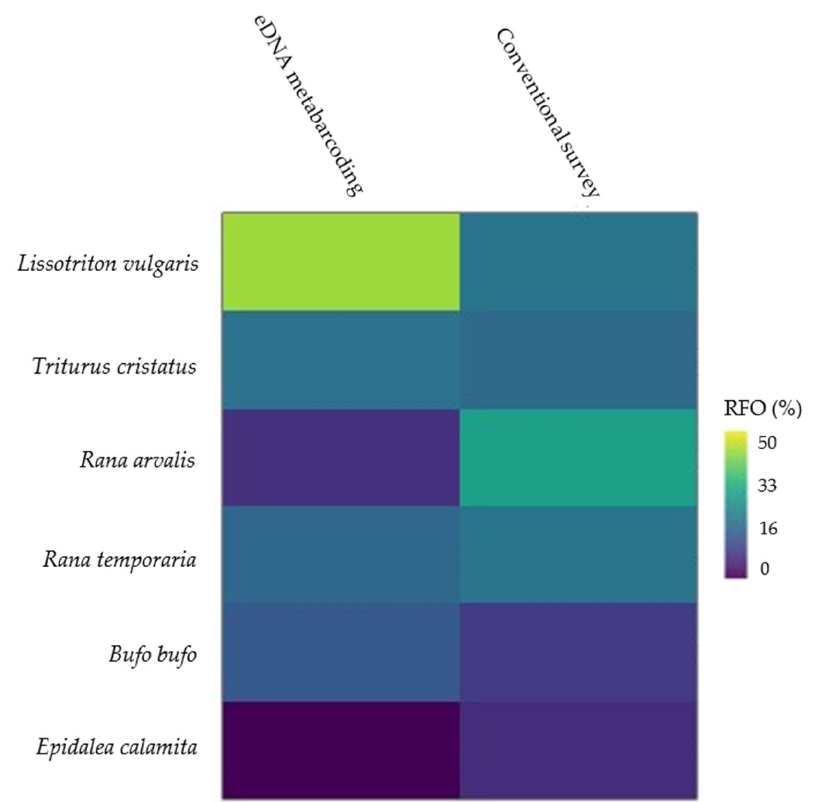
Figure 4. Matrix plot of the relative frequency of occurrence. A visualization of the relative frequency of occurrence (RFO) of amphibian species ranging from 0% (blue) to 50% (yellow) for each species and survey method applied in the present study.